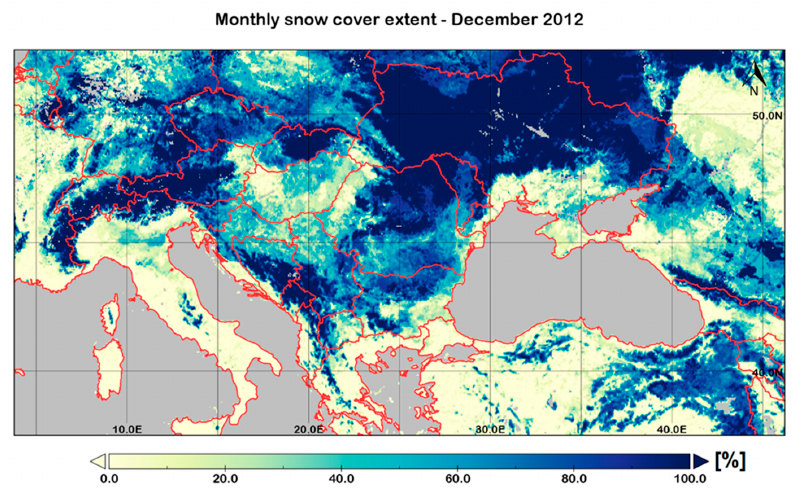
Figure 8. Large scale snow cover in December 2012. The snow cover data was provided by MODIS/Terra Snow Cover.